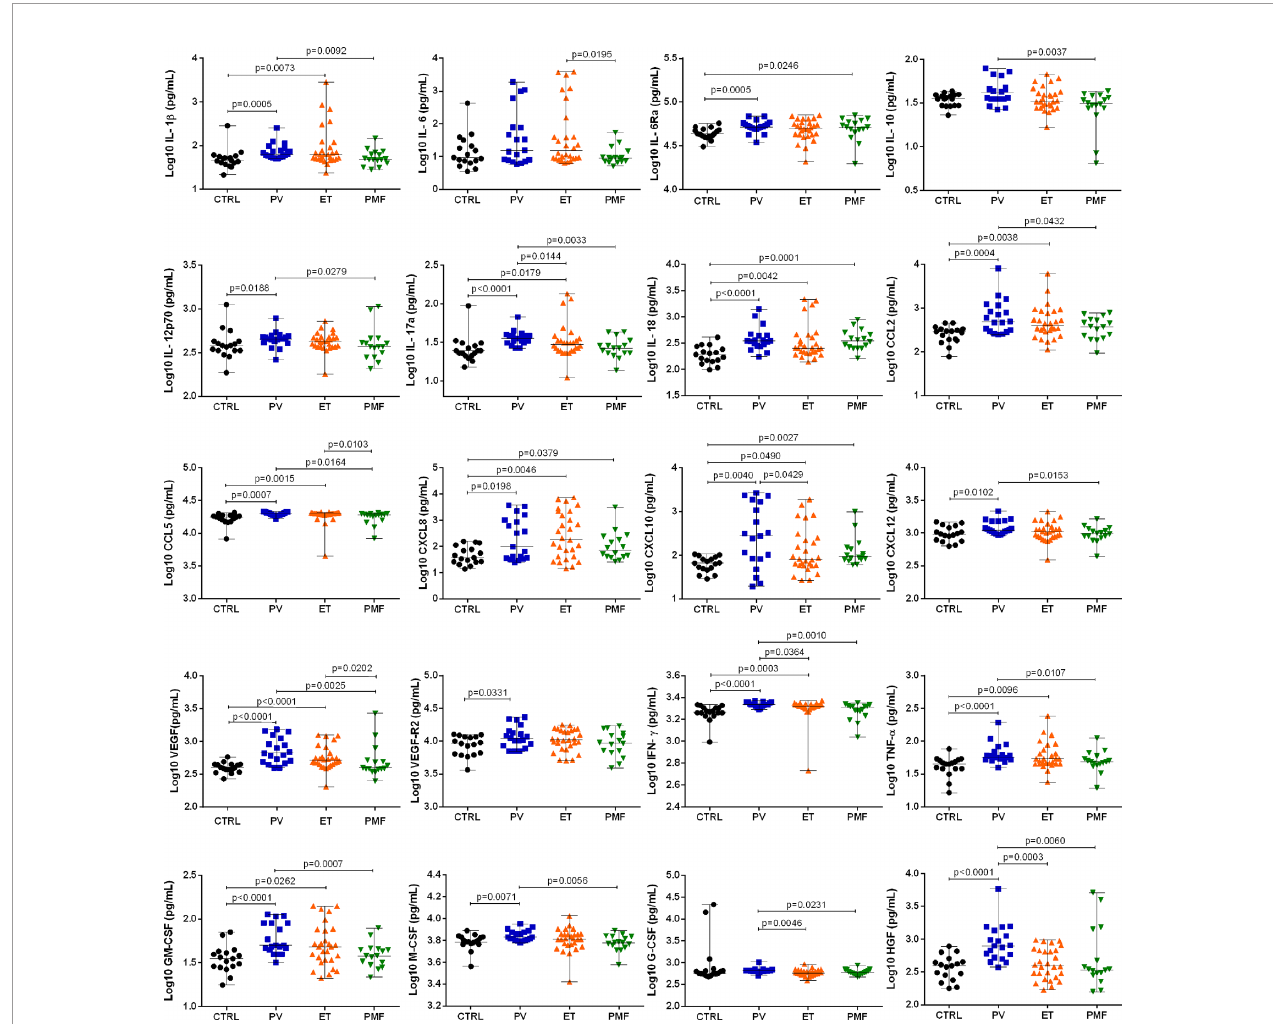
FIGURE 1 | Bone marrow plasma levels of in fl ammatory soluble mediators in healthy subjects (CTRL; n = 17) and patients with essential thrombocythemia (ET, n = 28), polycythemia vera (PV, n = 19), and primary myelo fi brosis (PMF, n = 16). The concentration of all the soluble mediators was determined using a Multiplex assay. Signi fi cant differences when p <0.05, Mann – Whitney